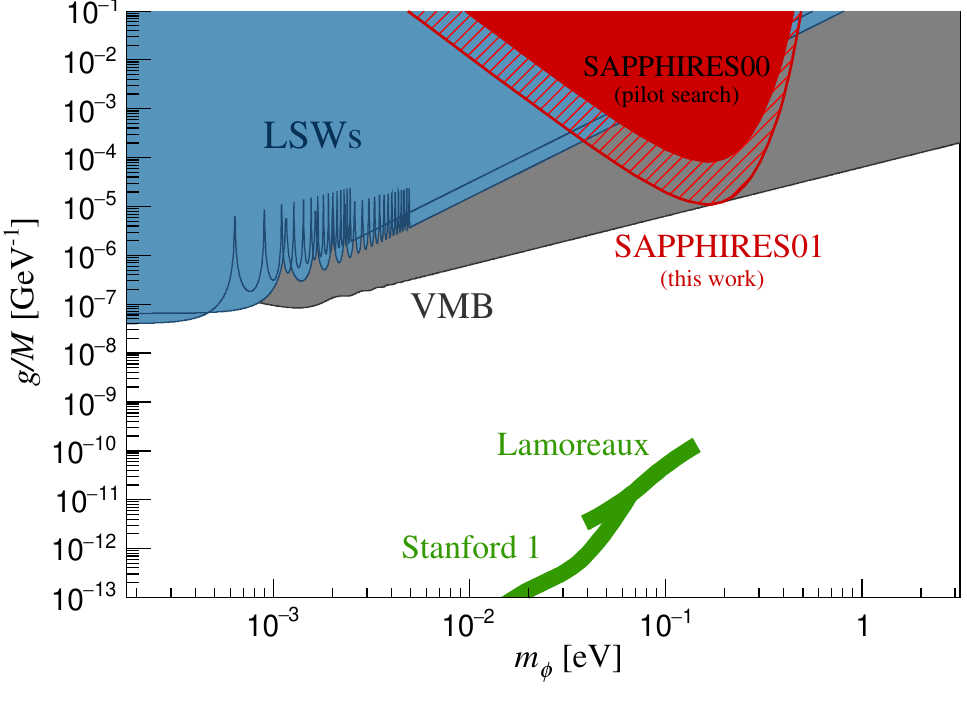
Figure 11 . Upper limit in the m φ − g/M parameter space for scalar field exchanges achieved in this work, SAPPHIRES01, represented by the red shaded area. The red filled area is from the pilot search, SAPPHIRES00 [11]. Limits from the LSW experiments (ALPS [7] and OSQAR [9]) and the VMB experiment (PVLAS [10]) are shown in the blue and gray areas, respectively. The green lines are exclusion limits from the non-Newtonian force searches (Stanford 1 [16]) and the Casimir force measurement (Lamoreaux